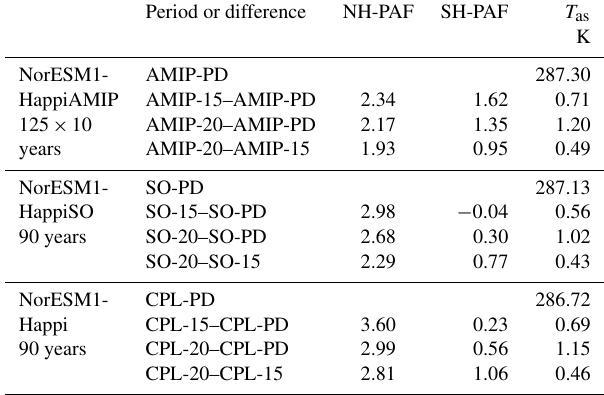
Table 3. The NH and SH polar amplification factor (NH-PAF and SH-PAF) and global-mean near-surface temperature ( T as ) in the PD experiments and differences associated with 1.5 ◦ C warming, 2.0 ◦ C warming, and the 0.5 ◦ C difference for NorESM1-Happi, NorESM1-HappiSO, and NorESM1-HappiAMIP. PAF is defined as (cid:49)T Polar /(cid:49)T Global , where T is the near-surface temperature, and the global and polar (poleward of 60 ◦ ) subscripts indicate the averaging region.